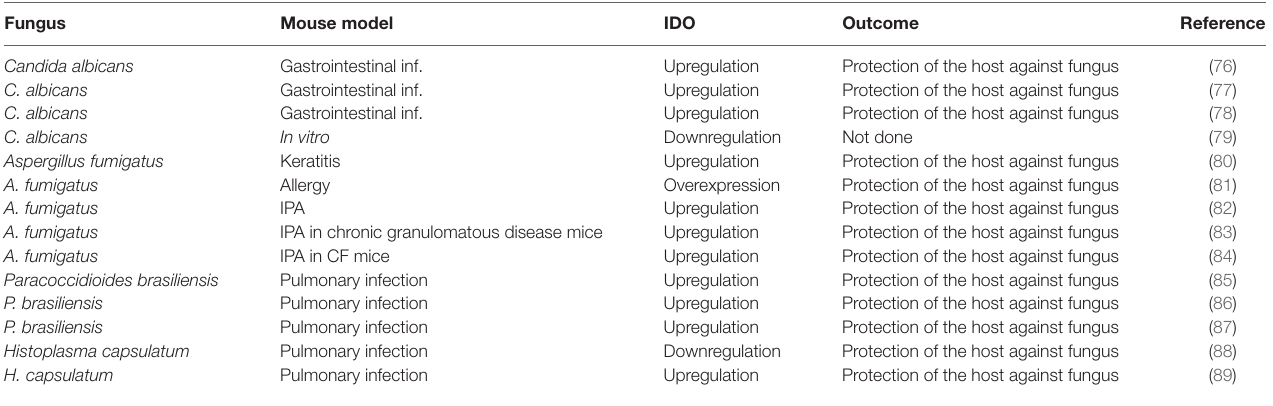
TAble 3 | Summary of studies where IDO enzyme activity was found to be implicated in fungal infections.